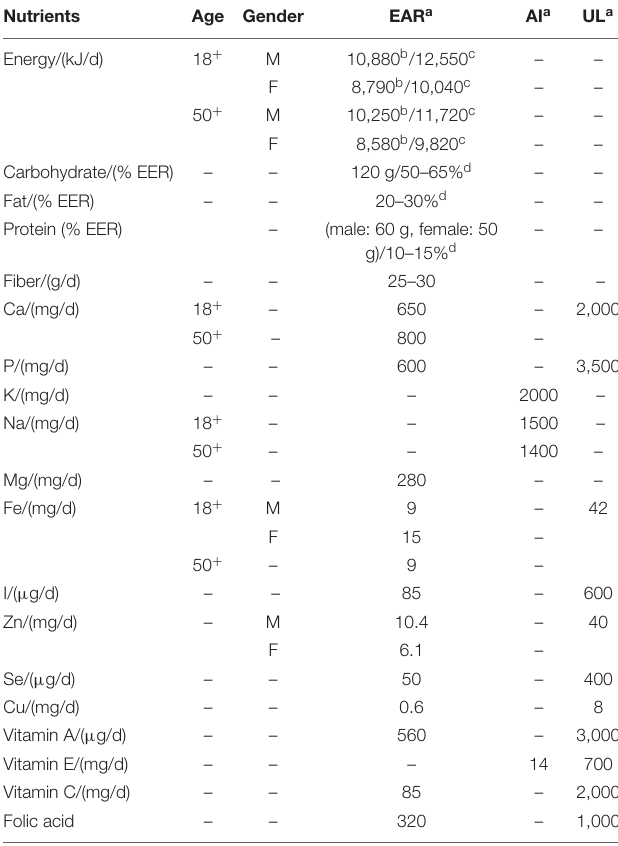
TABLE 2 | Reference values of nutrient intakes based on Chinese